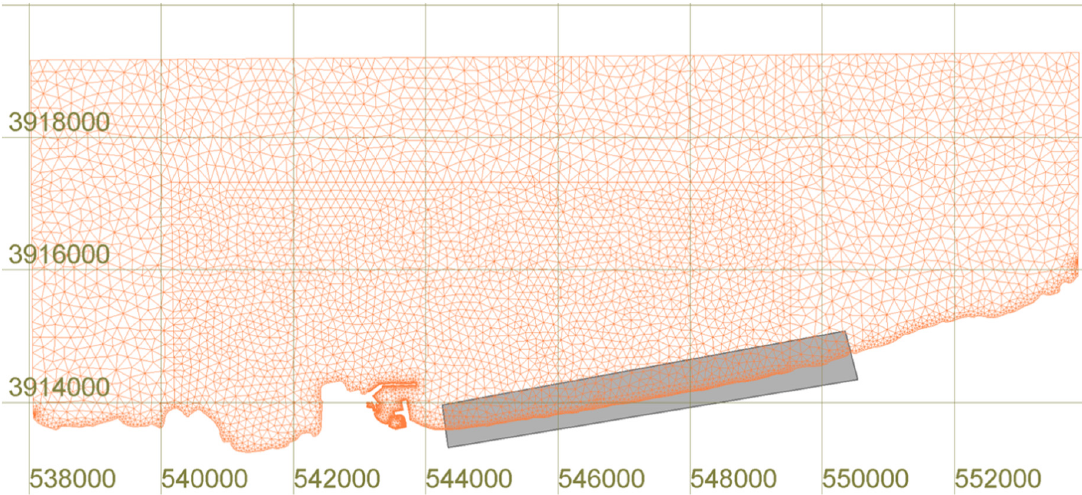
Figure 7. Finite element mesh showing the area (within the closed polygon) where the morphological model results will be evaluated.